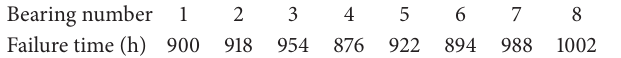
Figure 7: Vibration wave in the failure stage. Table 1: Failure data of